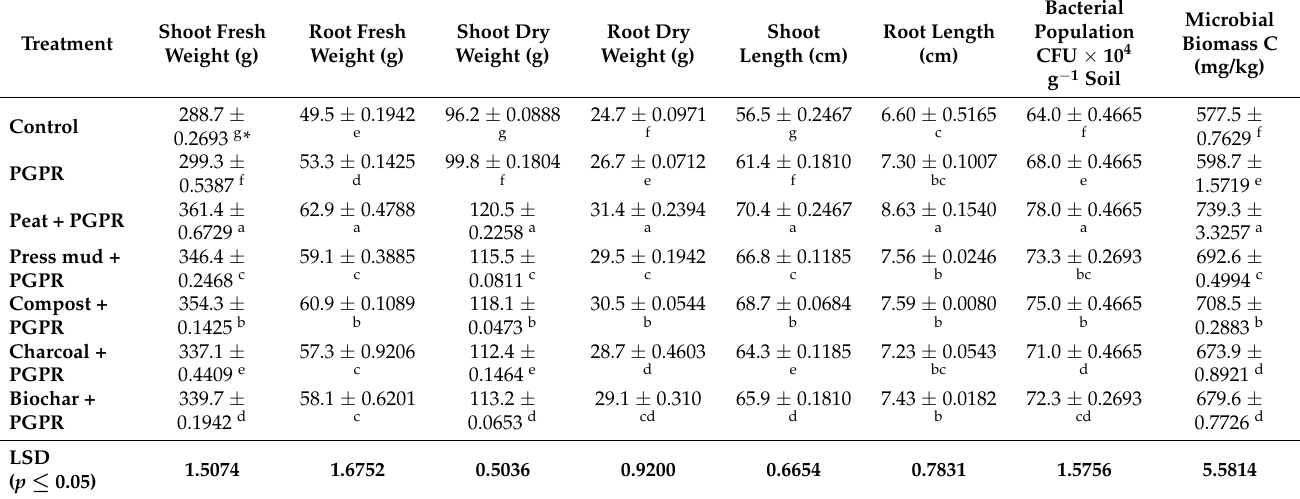
Table 5. Effect of different carrier materials on physiological parameters of okra in the field trial. Values are mean ± standard error of three